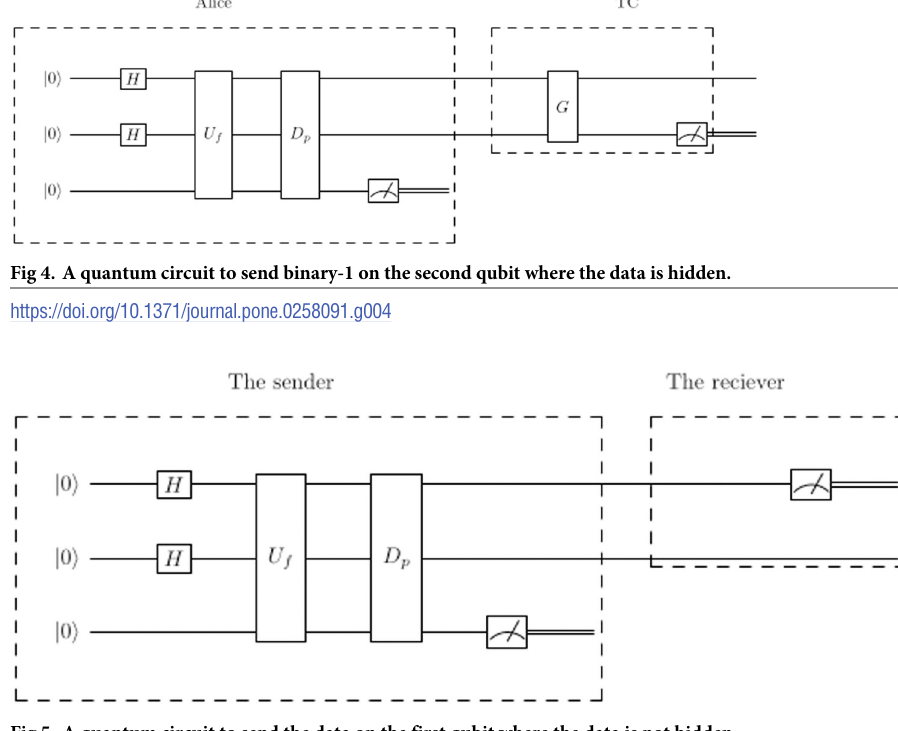
Fig 5. A quantum circuit to send the data on the first qubit where the data is not hidden.